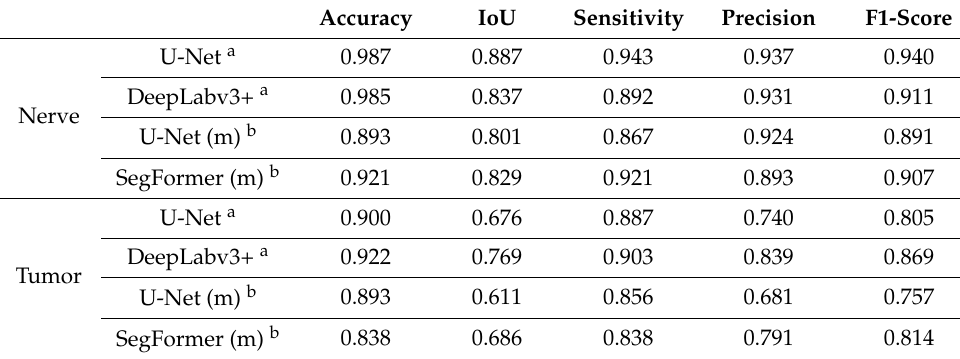
Table 2. Performance of the segmentation